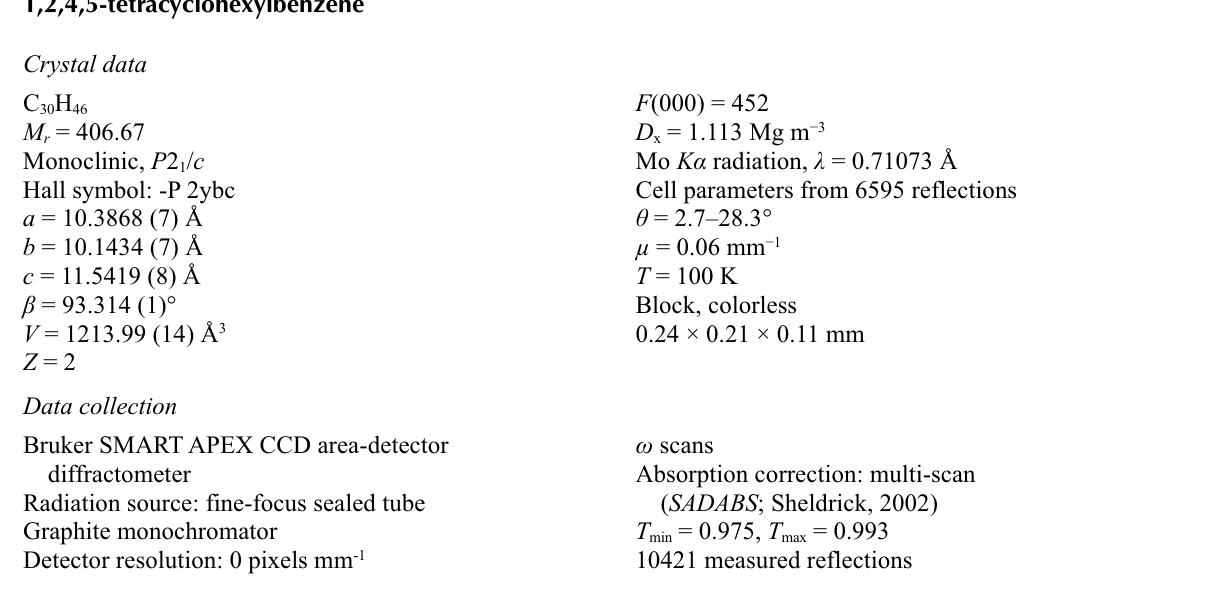
Molecular structure of the title compound. Displacement ellipsoids are drawn at the 50% probability level and H-atoms are represented by spheres of arbitrary radius. Primed atoms are related to unprimed atoms by the symmetry operation 0.5 - x , - y , -